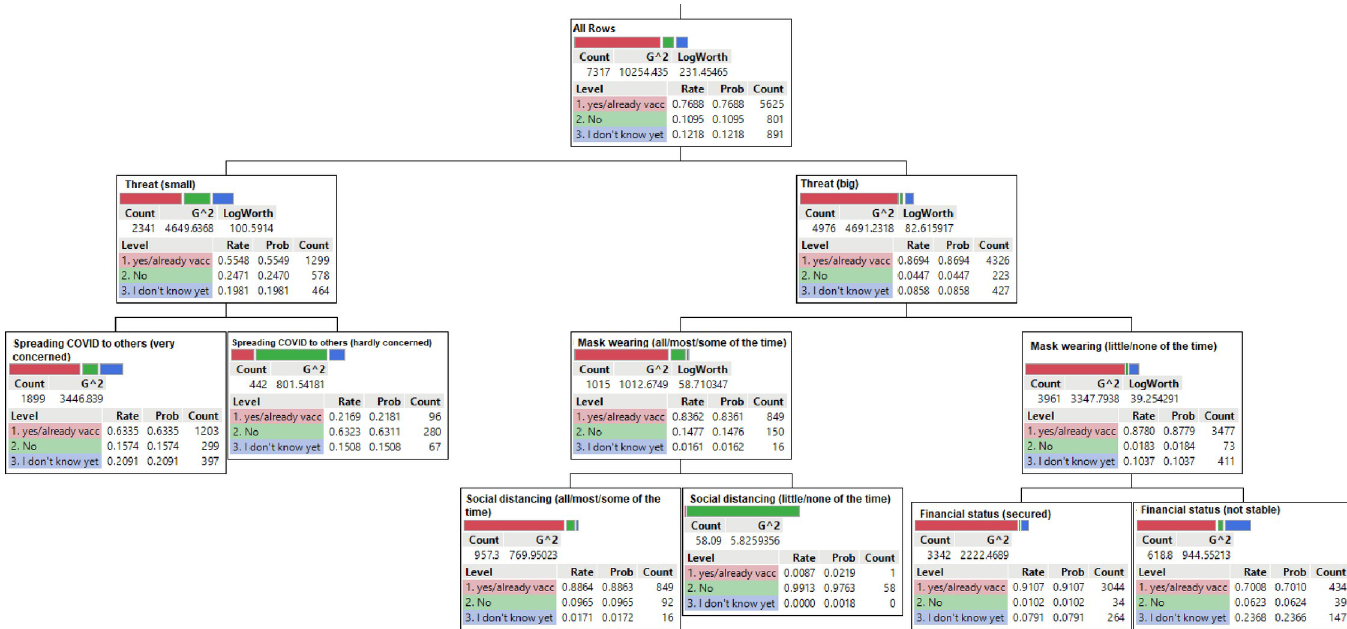
Fig 2. Decision tree model for COVID-19 vaccine intentions in Saskatchewan, Canada. To interpret the decision tree, the branches should be traced from the root node—vaccine intentions (i.e., first node with highest information gain) to the subsets of root node (i.e., internal nodes). The internal nodes (i.e., predictor variables) represent attributes associated with vaccine intentions (i.e., root node) based on statistical probabilities. The first set of internal nodes represents the most influential predictors of the outcome variable. The furthest nodes are the terminal nodes or leaves.